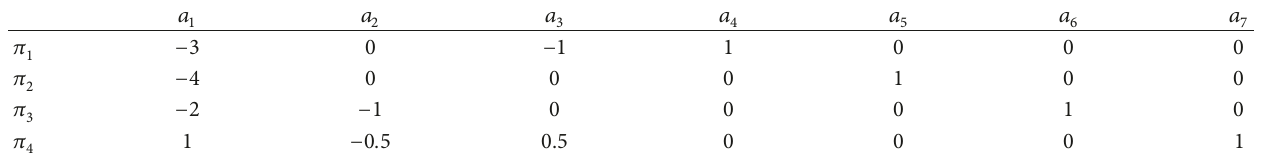
Table 3: 𝜋 matrix.